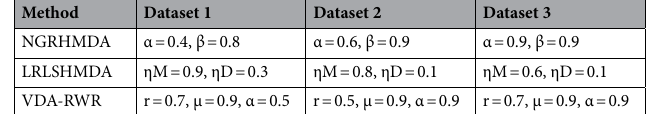
Table 1. The optimal values of parameters in VDA-RWR, NGRHMDA and